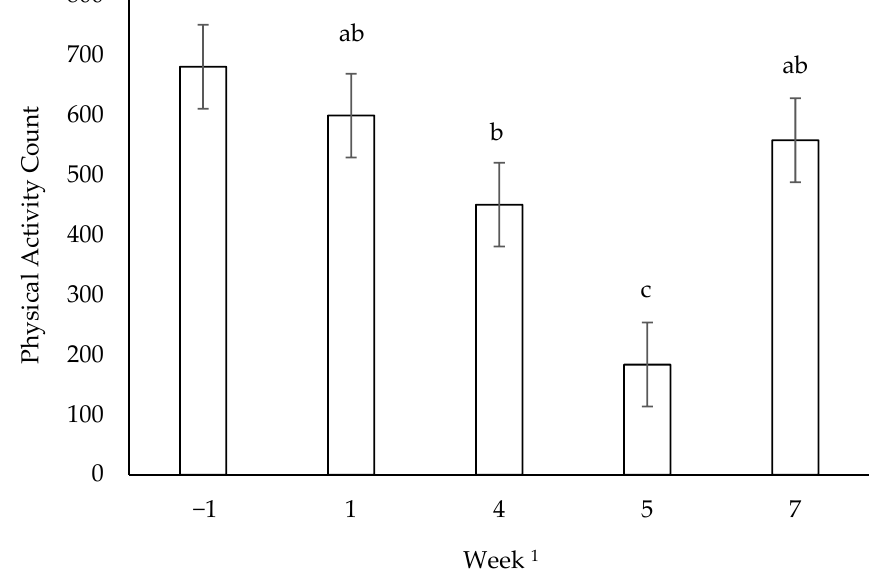
Figure 3. Mean voluntary physical activity counts on run days for all dogs undergoing 10 weeks of incremental conditioning; abc columns with different letters are different ( p < 0.05); error bars represent standard error of the mean; n = 14 for weeks − 1 and 1; n = 12 for weeks 4, 5 and 7; 1 distances run were 3 km (week − 1), 11.2 km (week 1), 30.1 km (week 4), 35.8 km (week 5) and 36 km (week 7).